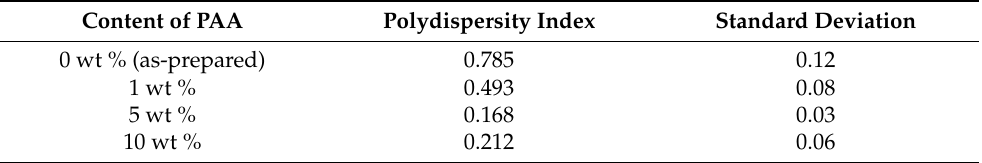
Table 1. PDIs of as-prepared Fe 3 O 4 and Fe 3 O 4 modified using 1, 5, and 10 wt %